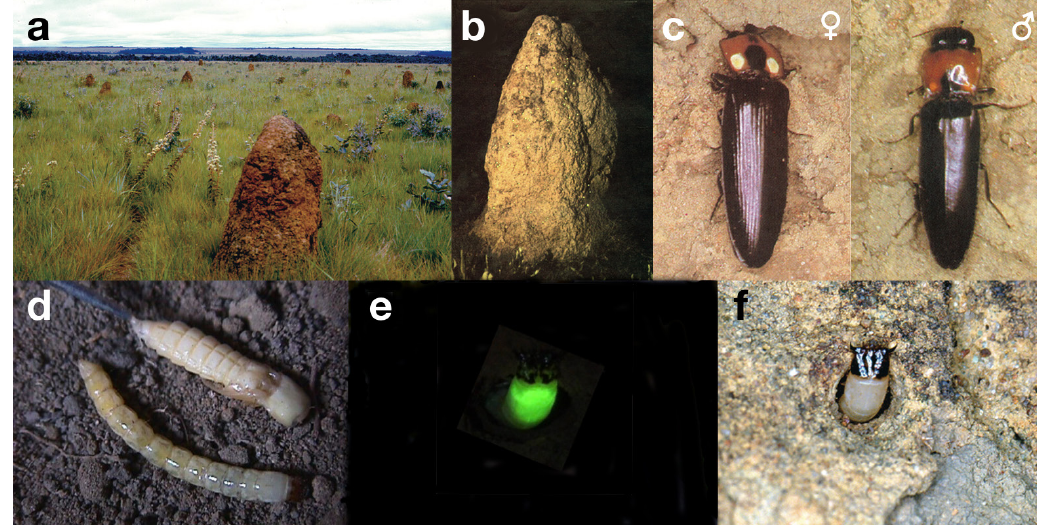
Figure 7 - Photographs of a luminous termite mound ( a, b ), Pyrearinus termitilluminans adults ( c ), pupa and larva ( d ) and a larva emitting green light from the prothorax hunting in the nest tunnel surface exits ( e, f ). Photos kindly provided by Sergio A. Vanin (IB-USP) and Cassius V. Stevani (IQUSP). Reproduced from Bechara and Viviani (2015). Copyright 2015 Brazilian Chemical Society.